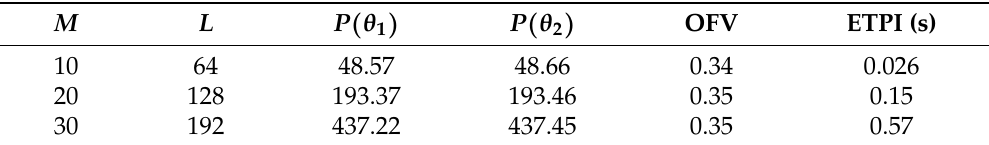
Table 1. The performance of the proposed algorithm for the joint design of the transmit beampattern and the PSDs of